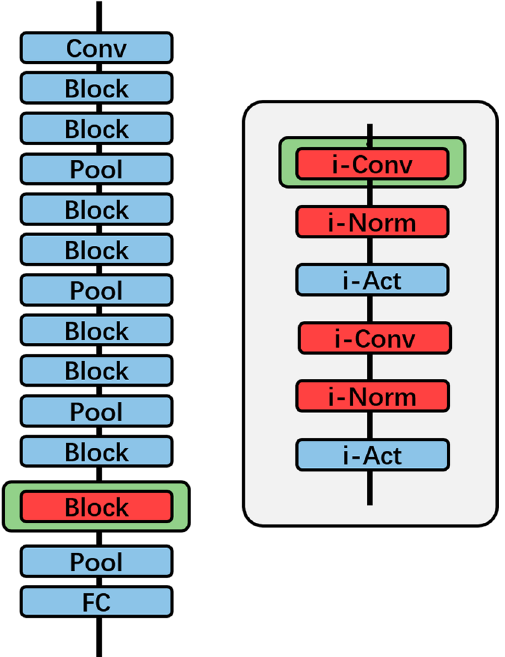
Fig. 7 Illustration of a layer-wise invertible architecture and its memory